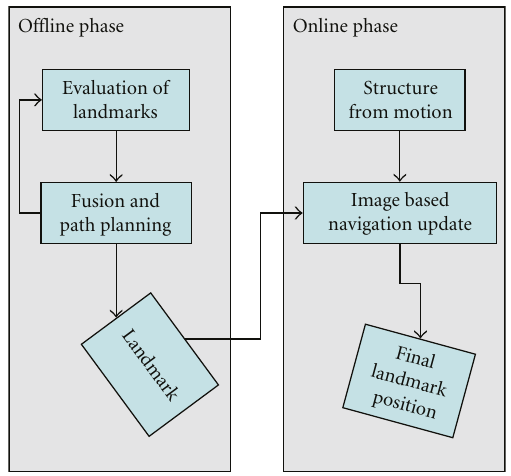
Figure 1: Overview of our landmark-based navigation system. In the o ffl ine phase before the mission landmarks are evaluated and fused with the path planning. During the online phase the navigation data are updated by mean of the registation of the landmarks with the SfM point